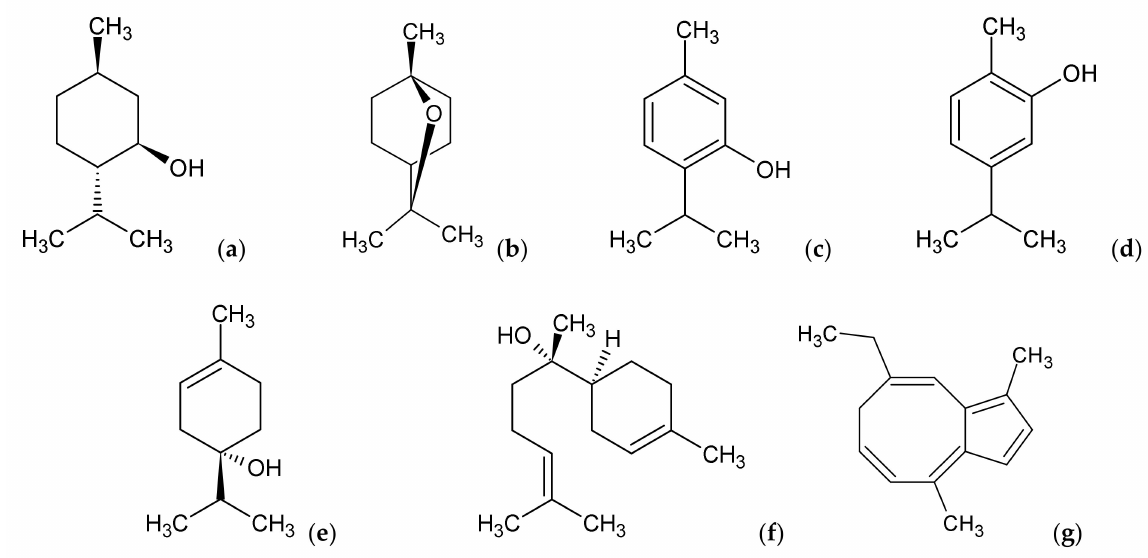
Figure 5. Selected monoterpenes: ( − )-menthol ( a ), 1,8-cineole ( b ), thymol ( c ), carvacrol ( d ), terpinen-4-ol ( e ) and sesquiter- penes: ( − )- α -bisabolol ( f ), chamazulene ( g